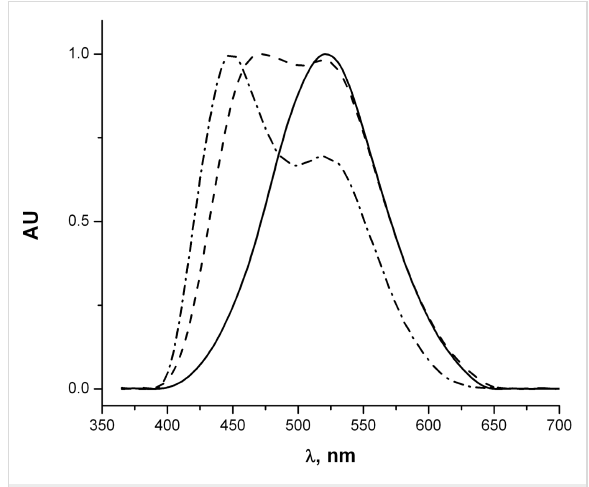
Figure 3: Normalized fluorescence spectra of 4 in ethanol at different concentrations: (solid line) 10 − 4 M; (dashed line) 10 − 5 M; (dashed-dot) 10 − 6 M.